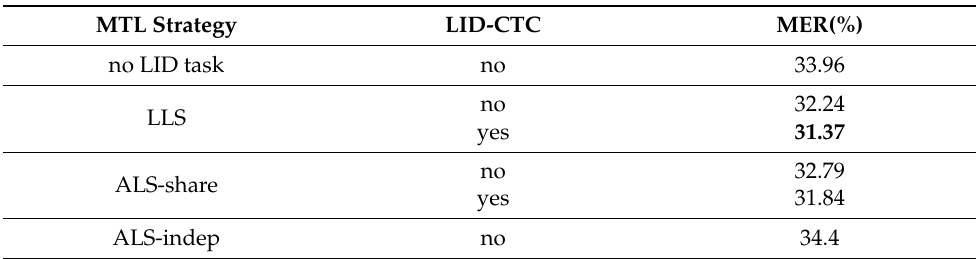
Table 3. MER(%) of ASR task corresponding to three MTL implementations: LLS, ALS-share and